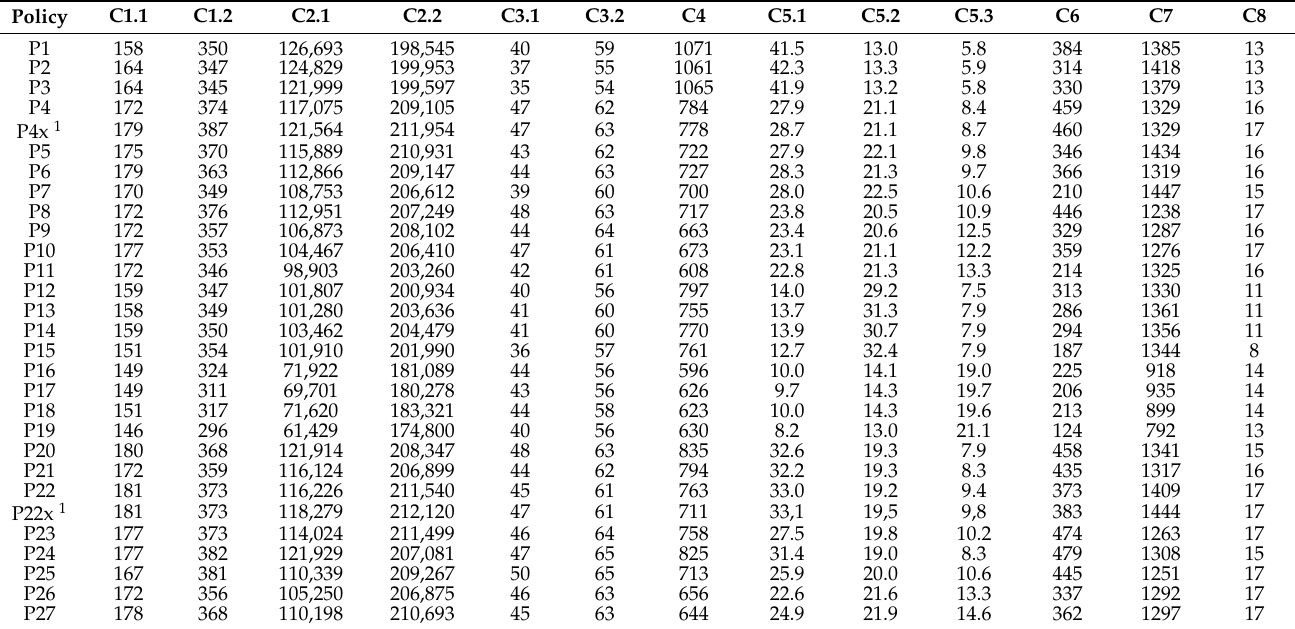
Table A4. Results—the best values of all the criteria computed for all the alternatives assigned to a given policy.